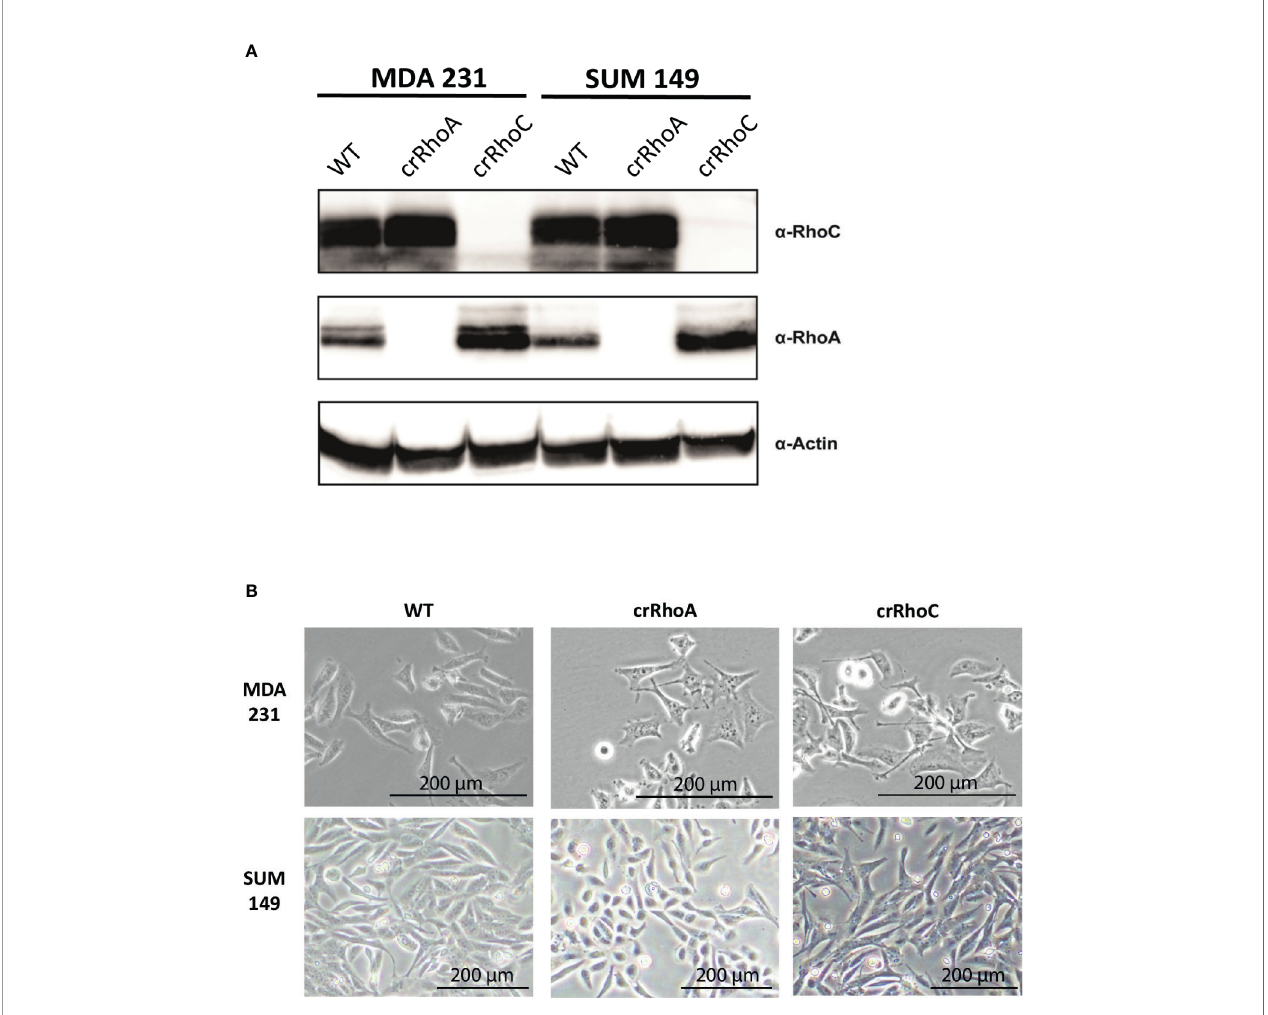
FIGURE 1 | Rho knockout changes expression and morphology of cells. (A) Validation of CRISPR-Cas9 knockout of RhoA and RhoC via Western Blot. (B) Bright fi eld images of wild-type, crRhoA, and crRhoC cells. RhoA knockout markedly changes the morphology of both MDA 231 and SUM 149 cells, leading to a consistent “ triangle ” shape in the MDA 231s and a rounded shape in the SUM 149s. RhoC knockout changes cell morphology more subtly, leading to a consistent “ crescent ” shape in the MDA 231s and a more cuboidal shape in the SUM 149s. Scale bars = 200 m